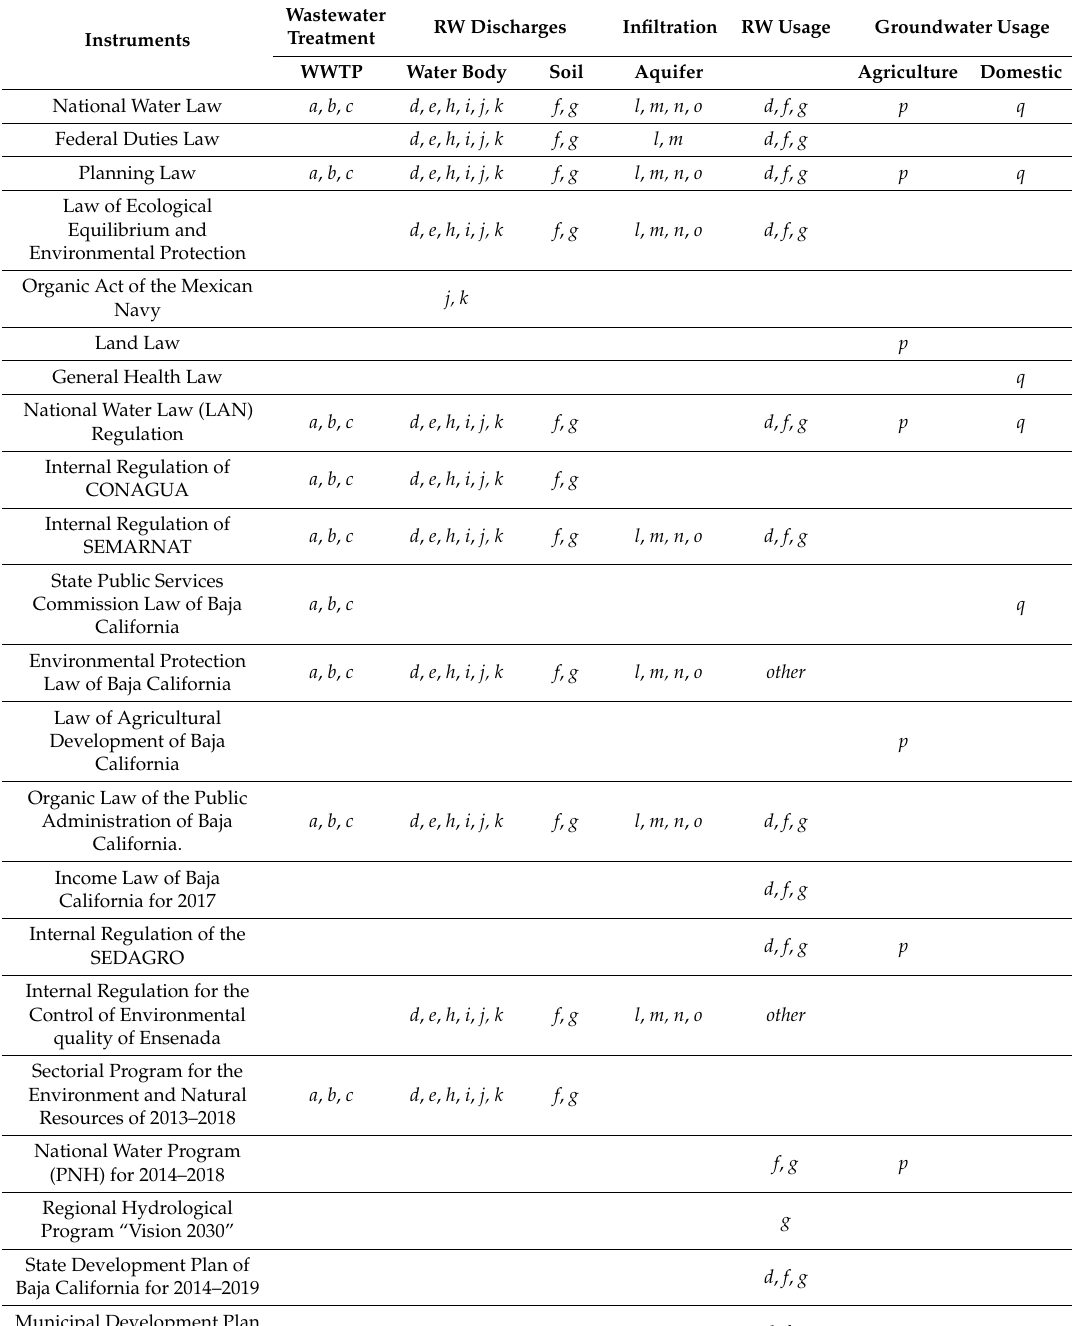
Table 4. Legal and management instruments associated to the water cycle of the Maneadero Valley in Figure